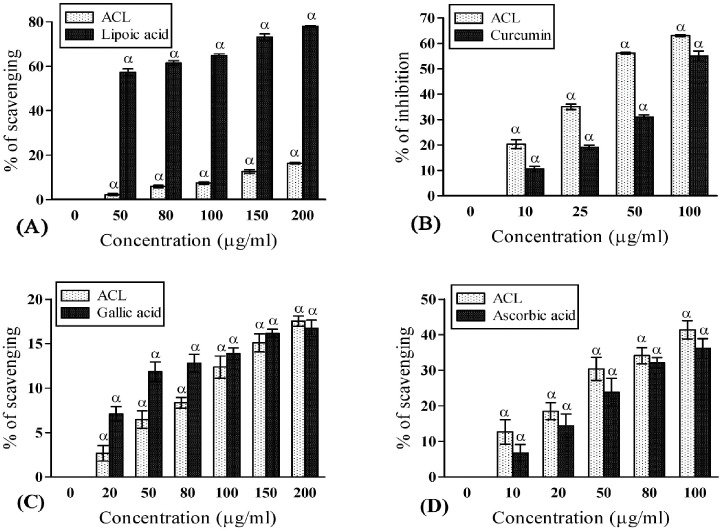
Free-radical scavenging potentials of ACL extract.(A) Singlet oxygen scavenging capacities of ACL extract and standard lipoic acid (IC50 value: ACL = 1103.79±24.69μg/ml and lipoic acid = 48.40±2.02μg/ml; p<0.001). (B) Nitric oxide (NO) scavenging activities of ACL extract and standard Curcumin (IC50 value: ACL = 45.57±1.33μg/ml and curcumin = 96.88±5.09μg/ml; p<0.01). (C) Peroxynitrite scavenging activities of ACL extract and standard gallic acid (IC50 value: ACL = 854.05±59.96 μg/ml and gallic acid = 734.81±28.30 μg/ml; p>0.05). (D) Hypochlorous acid (HOCL) scavenging activities of ACL extract and standard ascorbic acid (IC50 value: ACL = 130.675±4.78 μg/ml and ascorbic acid = 165.91±16.31μg/ml; p<0.01). [Each value represents mean ±SD (n = 6); Where, α = p<0.001 Vs 0 μg/ml].